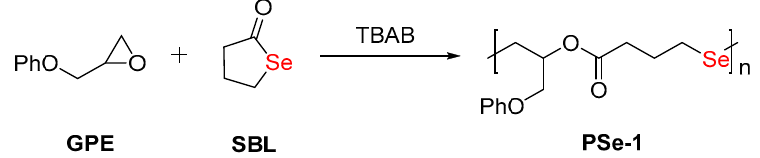
Table 1. Optimization of the copolymerization condition of glycidyl phenyl ether ( GPE) and γ - selenobutyrolactone ( SBL ) a